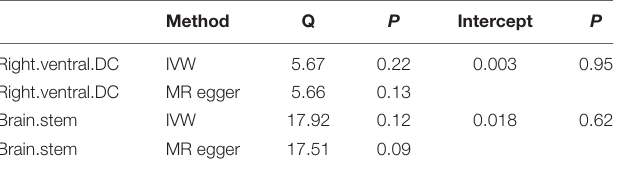
TABLE 4 | Sensitivity analysis between ROI and